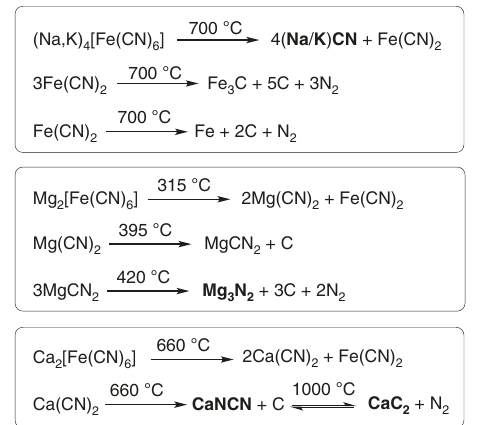
Fig. 2 Thermal metamorphosis of ferrocyanide salts. The products formed by heating ferrocyanide can be altered simply by exchanging the counter- ion of ferrocyanide and/or varying the temperature to which the salt